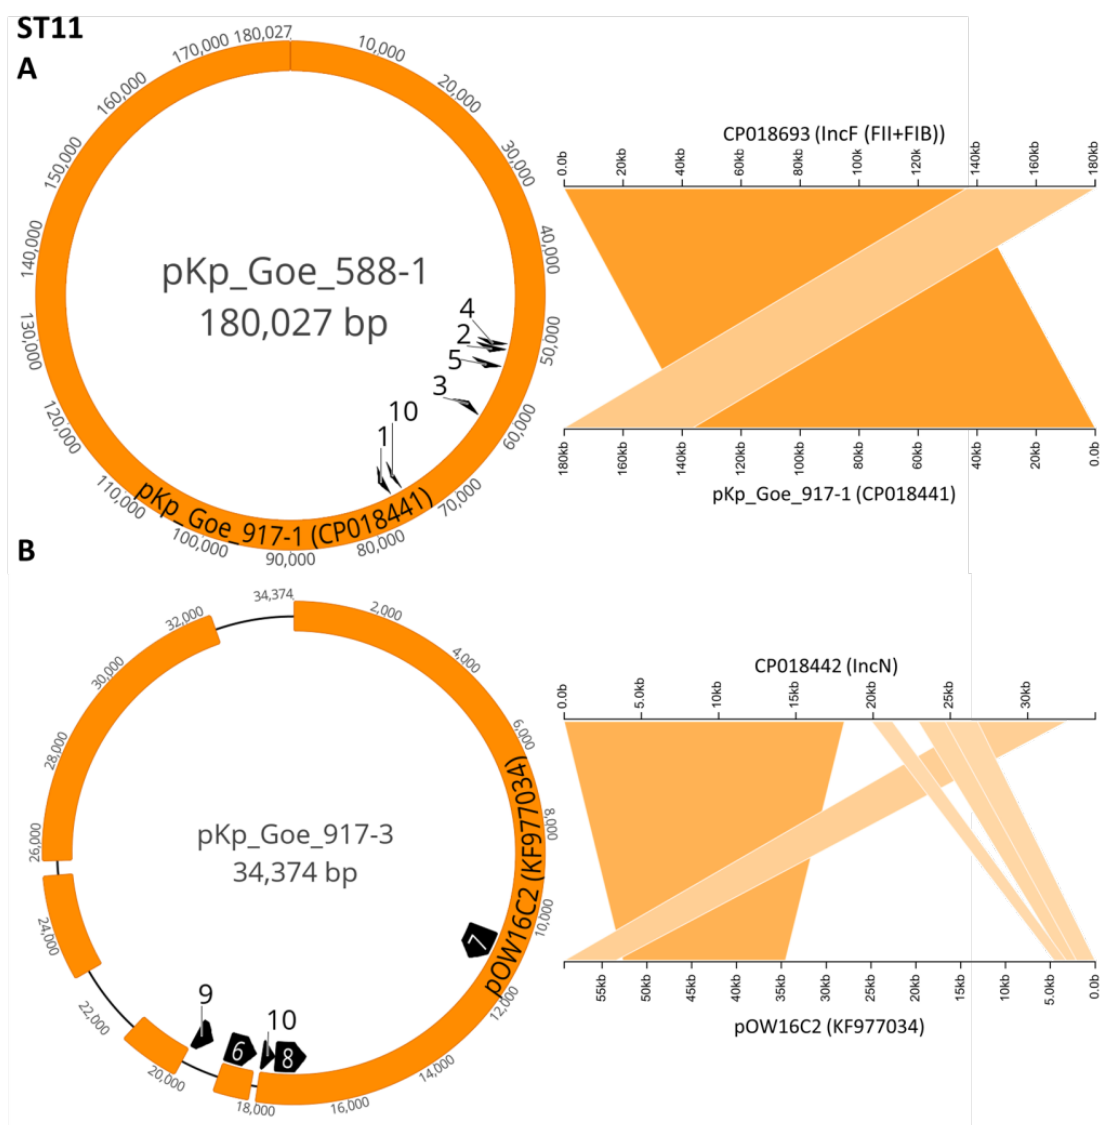
Figure 2. Example Plasmids found in OXA-48 producing Klebsiella pneumoniae isolates of sequence types ST11. Plasmids are mapped to possible origins found by NCBI BLAST as described in Appendix A Table A1. ( A ) Plasmid pKp_Goe_588-1 (CP018693, from Kp_Goe_821588) is mapped to pKp_Goe_917-1 (CP018441, query coverage 100%, identity 100%). ( B ) pKp_Goe_917-3 (CP018442, from Kp_Goe_822917) is mapped to pOW16C2 (KF977034, query coverage 92%, identity 99.99%). Resistance genes as predicted by ResFinder: 1: aph (3 (cid:48) )-Ia, 2: bla OXA - 1 , 3: bla CTX - M-15 , 4: aac (6 (cid:48) )-Ib-cr, 5: aac